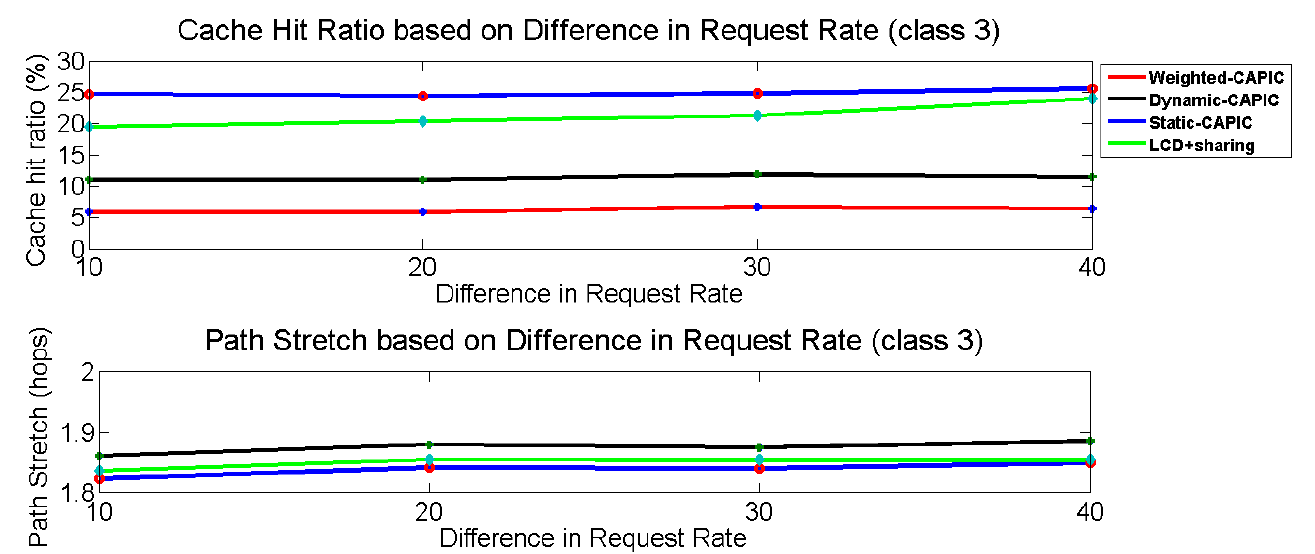
Figure 8. Cache hit ratio and path stretch of class 3 for various request rate